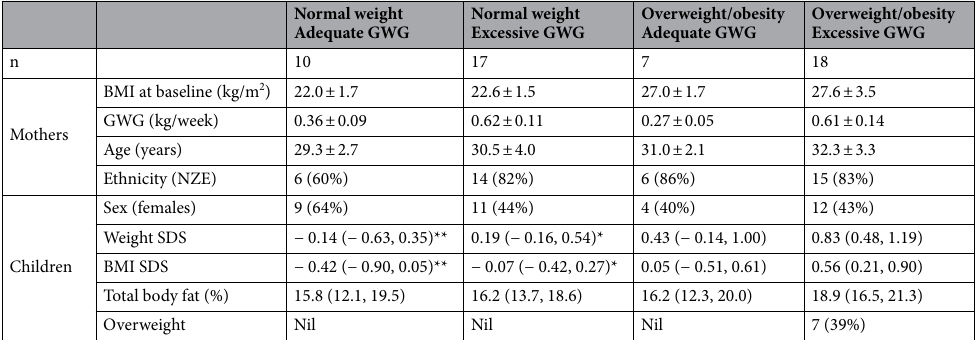
Table 7. Demographic and anthropometric outcomes at the 7-year follow-up in the offspring born to mothers stratified according to maternal body mass index (BMI) in mid-gestation and maternal gestational weight gain (GWG). Categorical data are n (%); continuous maternal data are means ± standard deviations; continuous data for the children are model-adjusted means and respective 95% confidence intervals derived from general linear models, adjusted for sex, age, and trial group allocation. NZE, New Zealand European; SDS, standard deviation score. *p < 0.05 and **p < 0.01 for pairwise differences in comparison to mothers with both overweight/obesity and excessive GWG.